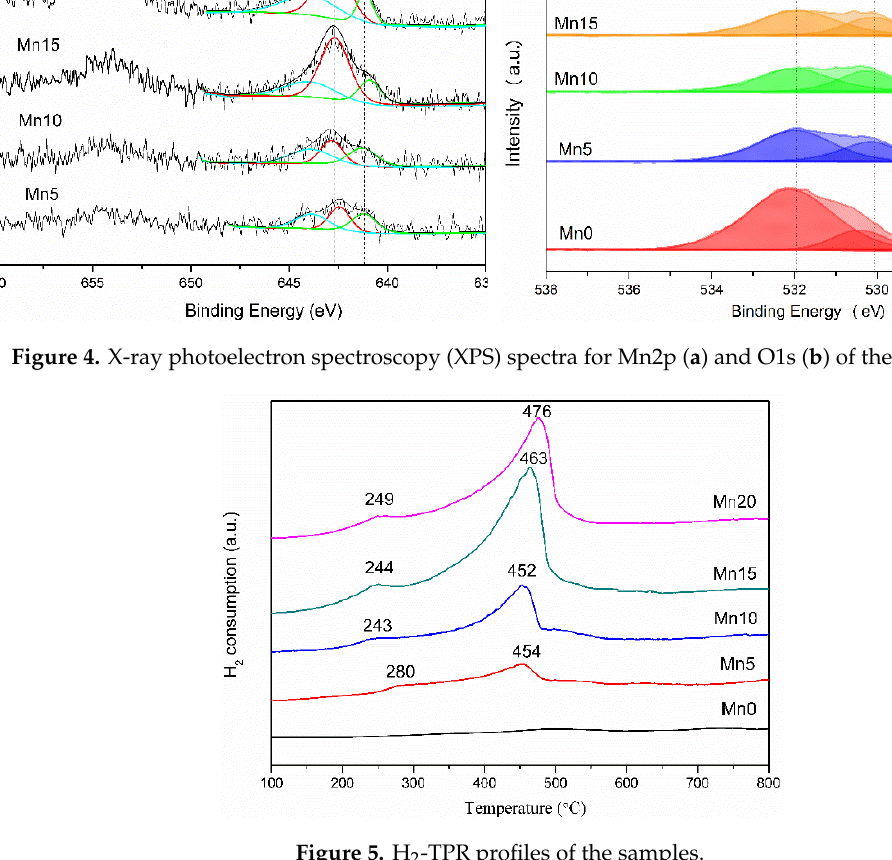
Figure 5. H 2 -TPR profiles of the samples. Table 3. X-ray photoelectron spectroscopy (XPS) and H 2 -TPR results of samples .